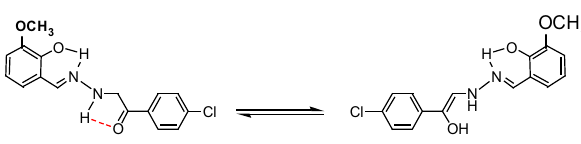
Figure 5: Tautomerism change in the methoxy - diim ligand from the keto to the enol form in the alkaline